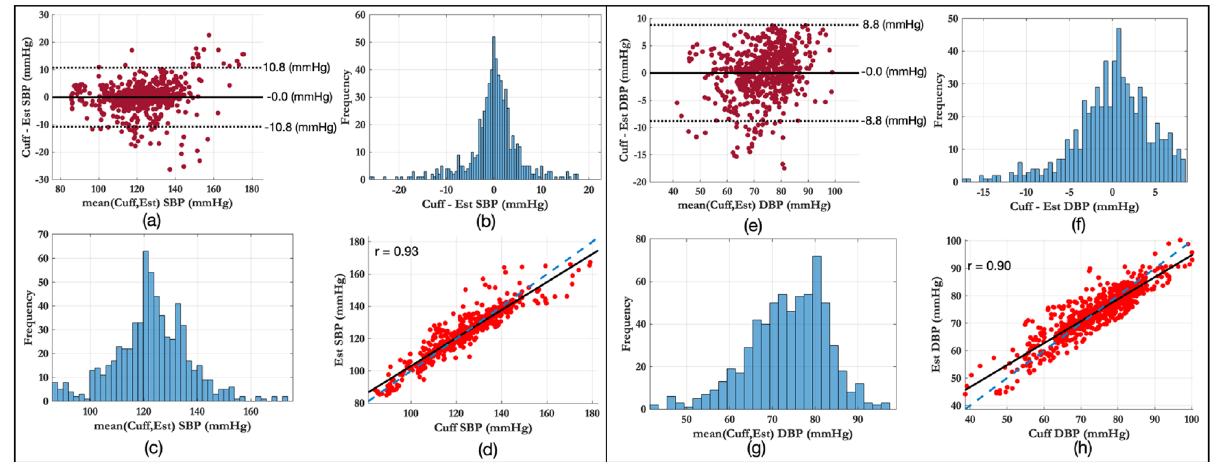
Figure 7. Agreement between the reference BP values from the sphygmomanometer cuff and the estimated BP values using PAT estimates and the inverse squared model. The left panel shows the results for SBP estimation, the right panel shows the results for DBP estimation. ( a , e ) The Bland–Altman plots shows no underlying bias. ( b , f ) The differences between the reference and estimated BP values. ( c , g ) The distribution of the mean values show that the BP values are within the expected physiological range. ( d , h ) The correlation is high, with an r of 0.93 for SBP and 0.92 for